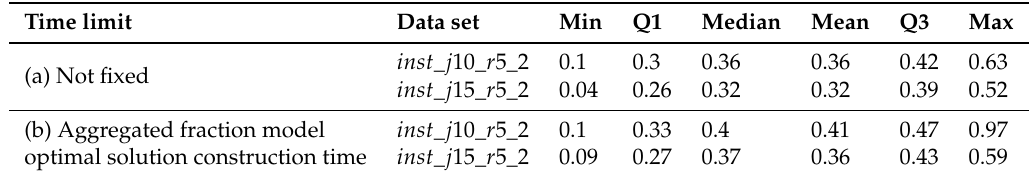
Table 6. X ( I ) values for instances of datasets inst _ j 10_ r 5_2 and inst _ j 15_ r 5_2, in two cases: (a) without